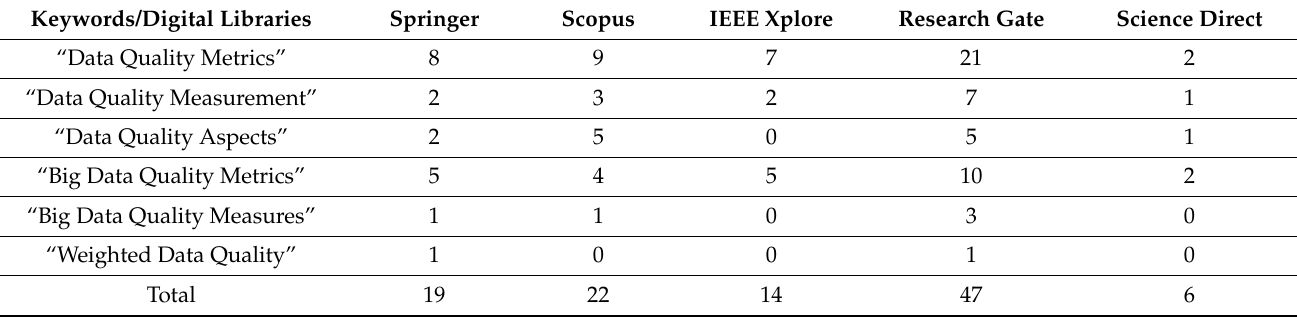
Table 1. Number of obtained articles by digital library and